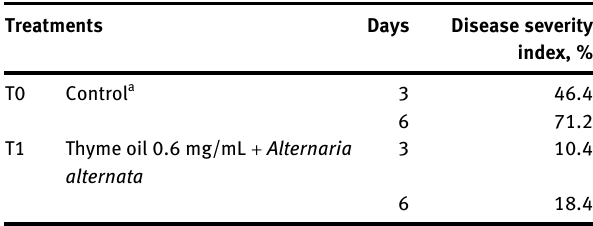
Table  : Effect of thyme oil (  .  mg/mL) concentration against Alternaria alternata after  and 